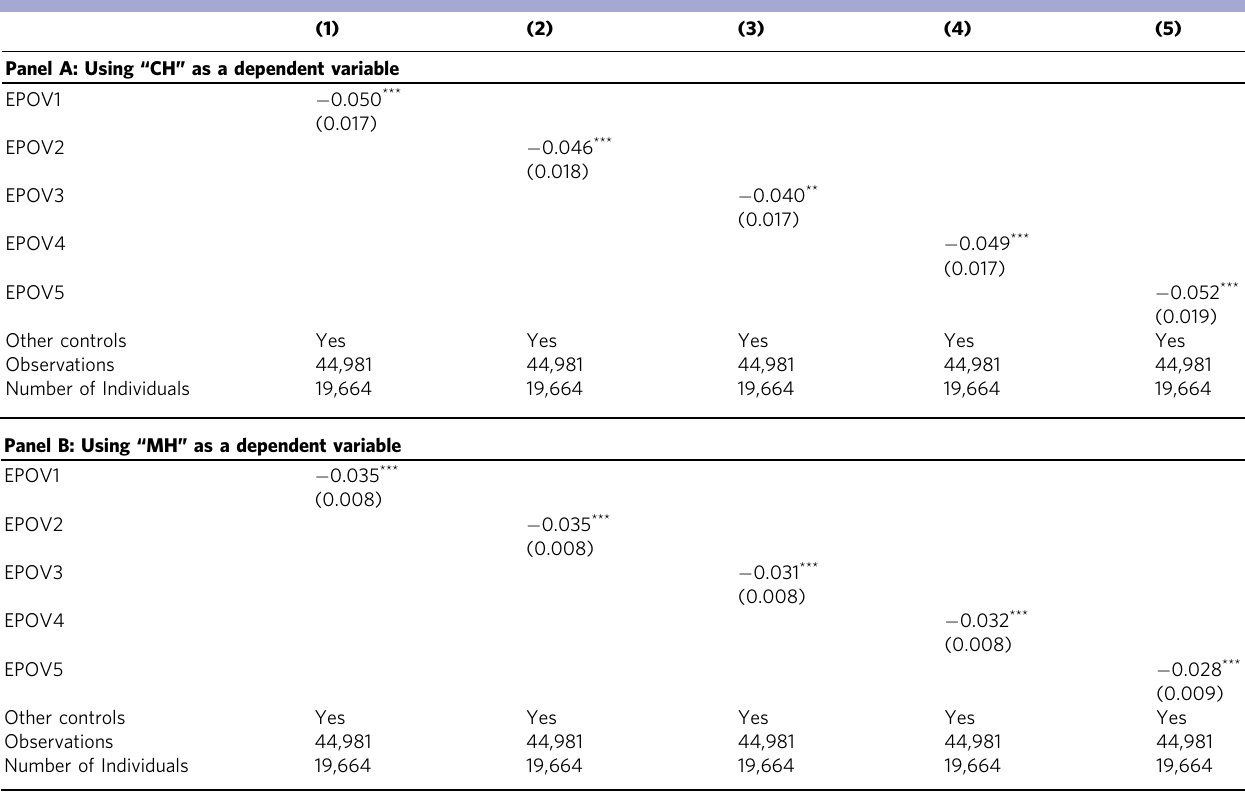
Panel A: Using “ CH ” as a dependent variable EPOV1